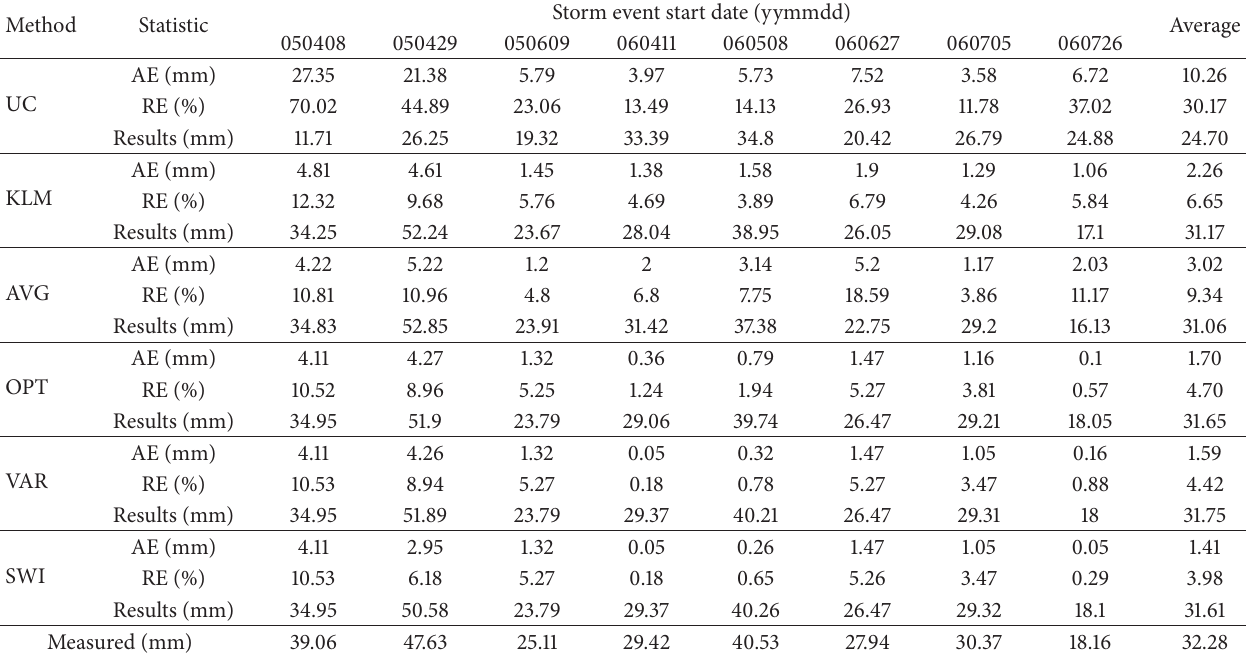
Table 2: Comparison of calibration results among different methods. UC is uncalibrated, KLM is Kalman filter, AVG is average calibration, OPT is optimum interpolation, VAR is variational calibration, and SWI is statistical weight